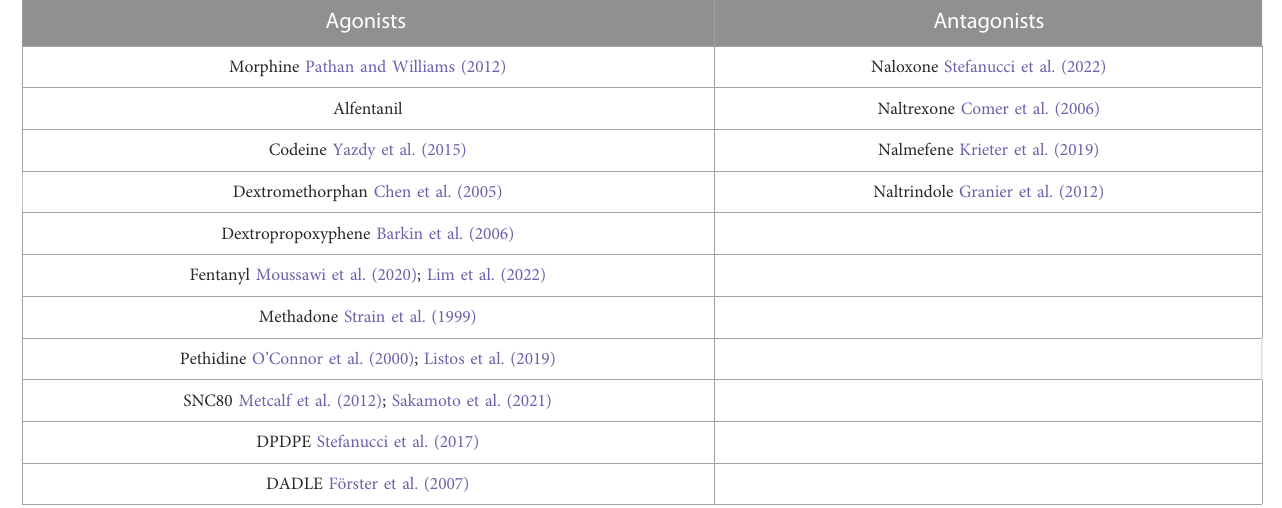
TABLE 2 Opioid agonist and antagonist